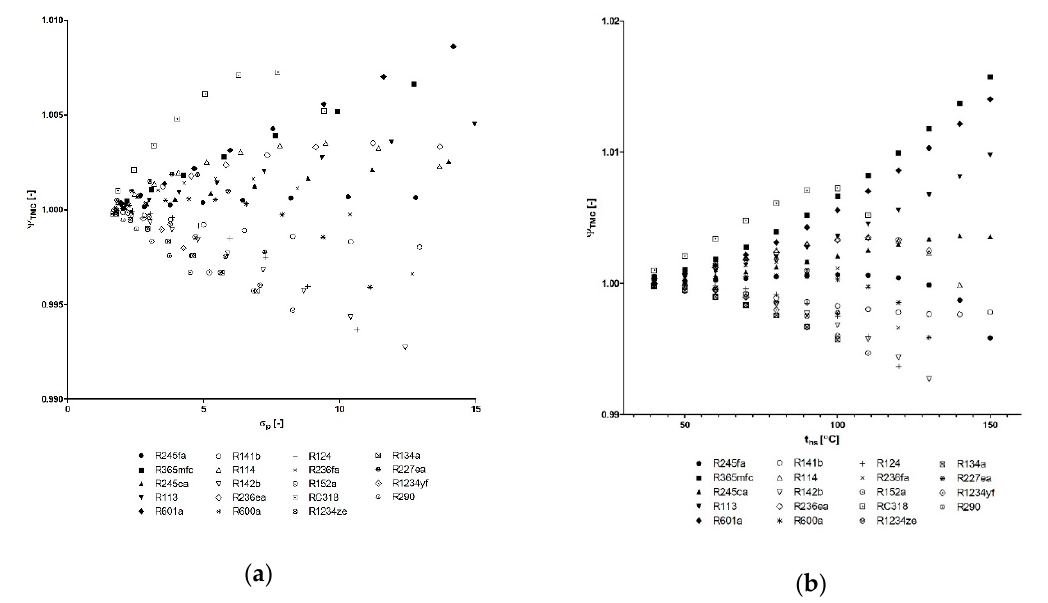
Figure 17. The variation of the σ V parameter vs. the pressure expansion ratio and heat source temperature: ( a ) σ TMC = f( σ P ); ( b ) σ TMC = f(t hs ).